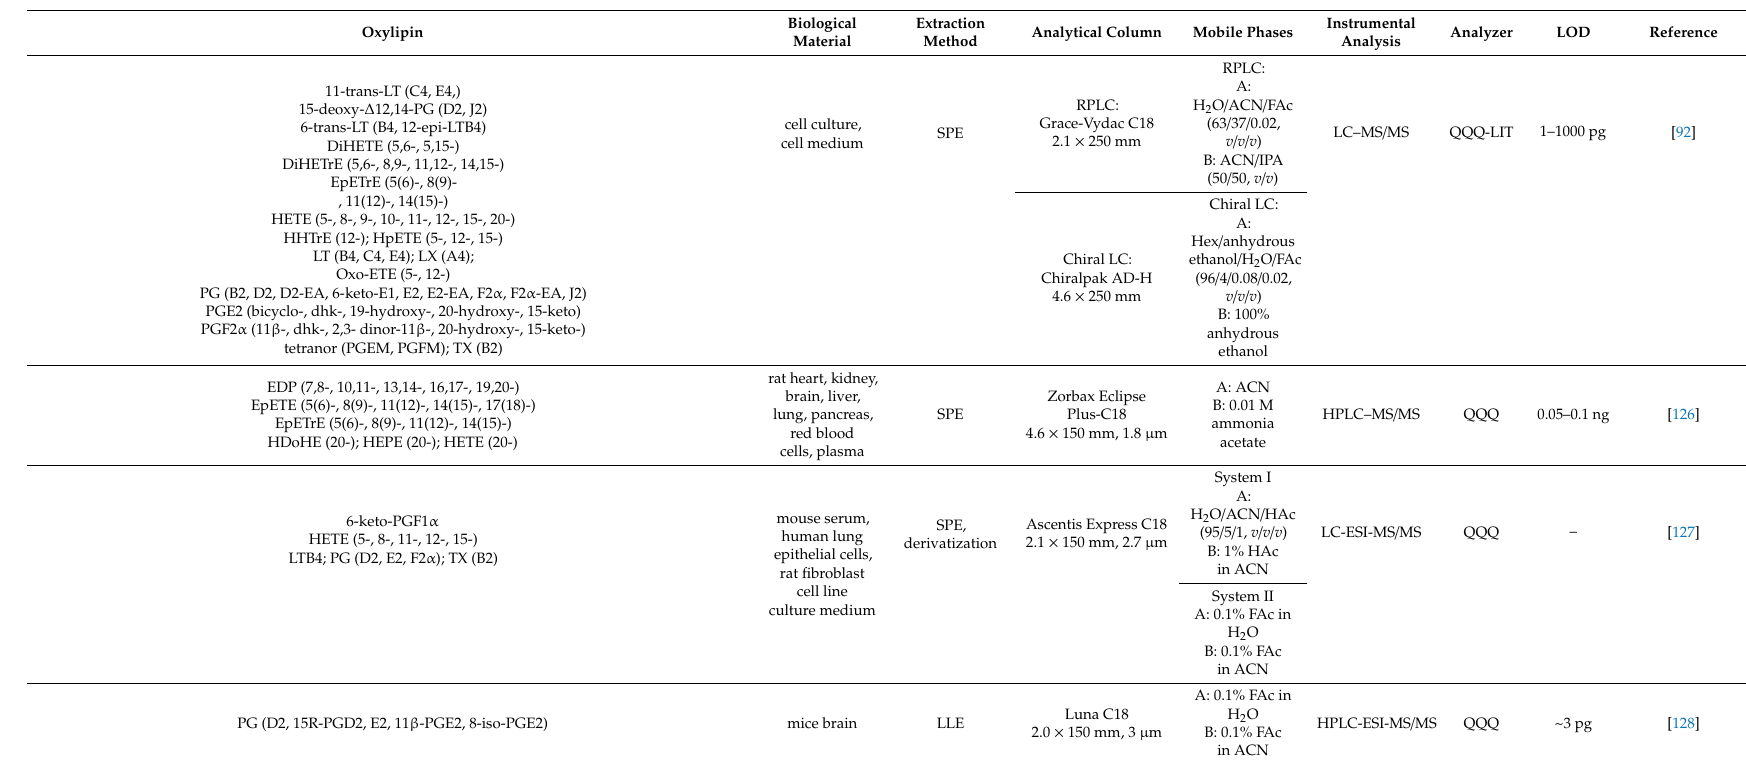
Table 2. Analytical methods based on LC–MS used in oxylipin